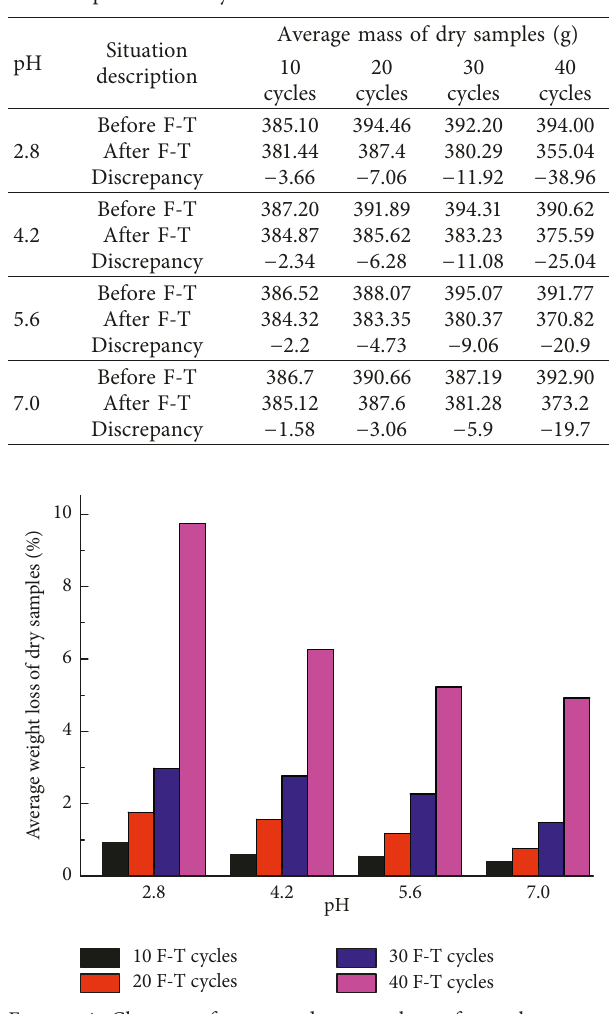
Figure 4: Changes of average dry mass loss of samples versus solutions’ pH and F-T cycles.